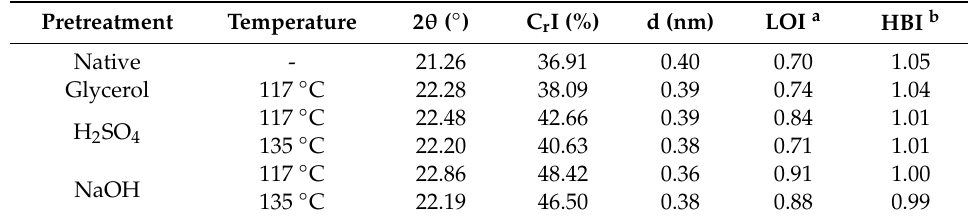
Figure 3. X-ray di ff raction patterns of untreated and pretreated bamboo solids ( a ), and layer spacing variation for the 002 crystal plane di ff raction peak ( b ). Table 3. Crystal values of raw and pretreated bamboo samples.